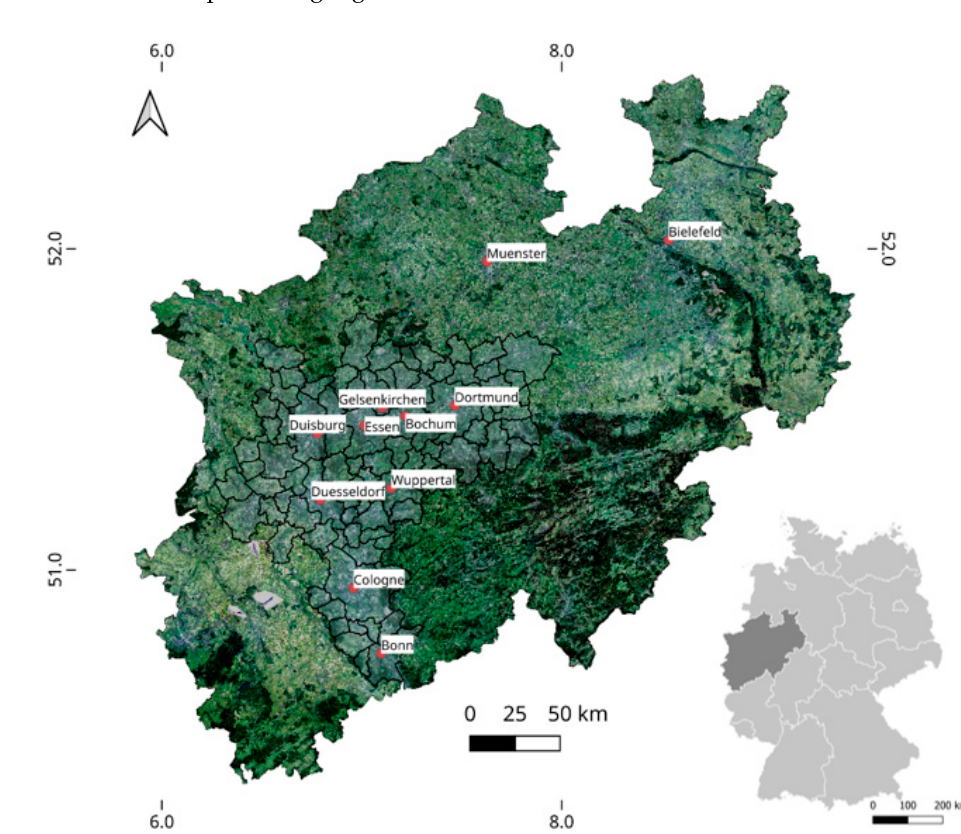
Figure 1. North Rhine-Westphalia (NRW), western Germany with the highlighted Rhine-Ruhr Metropolitan Area (RRMA) and cities with big population.